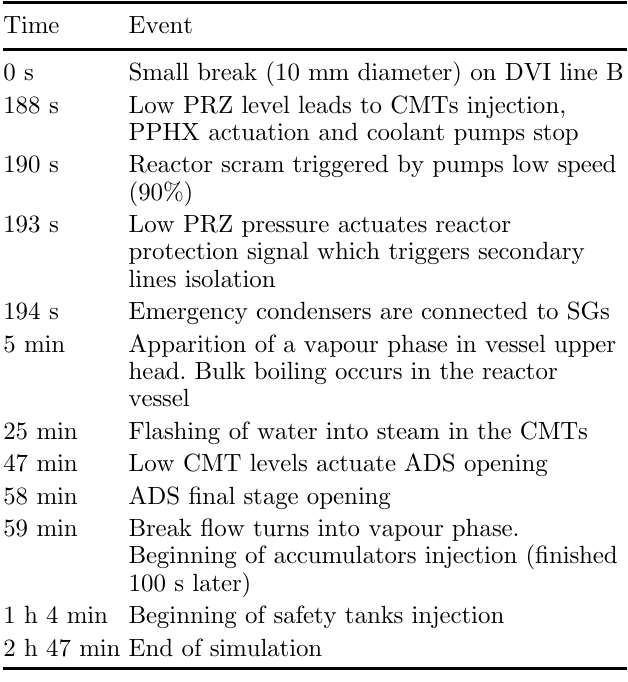
Table 6. Sequence of small break loss of coolant accident.